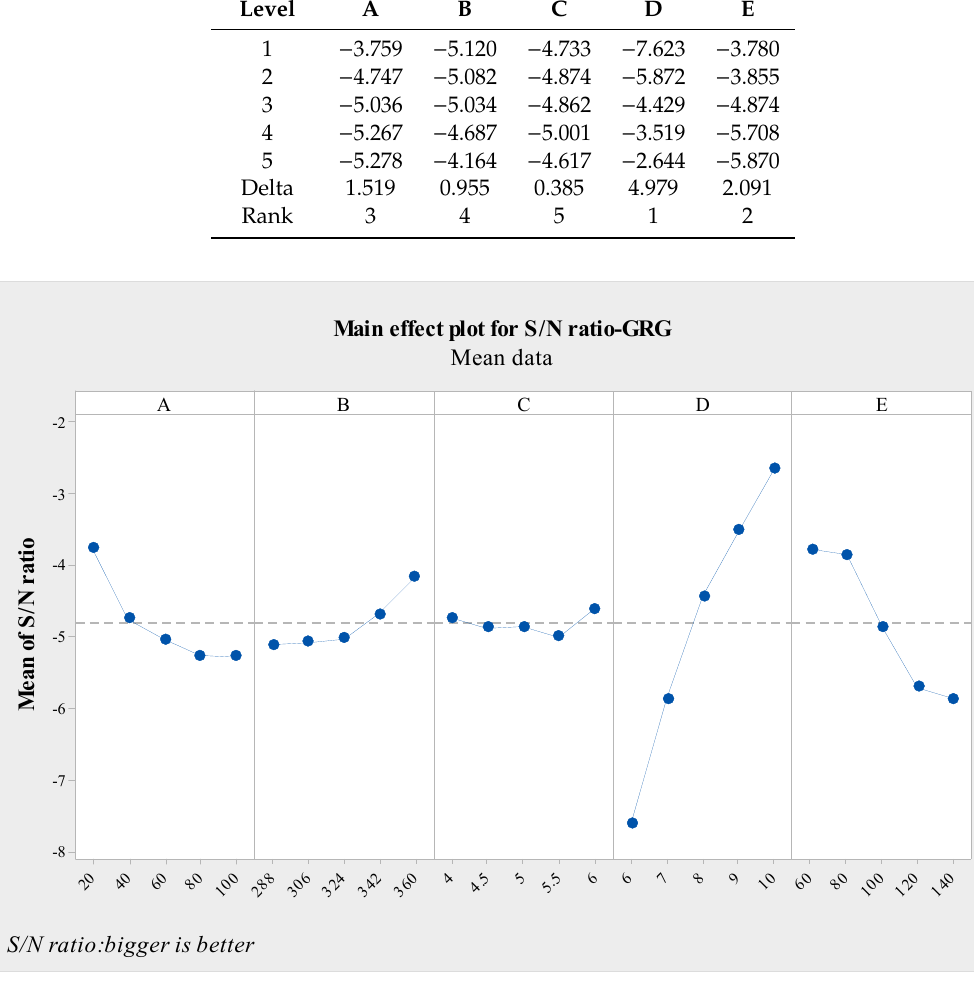
Figure 19. Contributions of each factor to the grey relational grade.